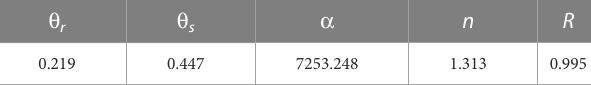
TABLE 2 The parameters of equation